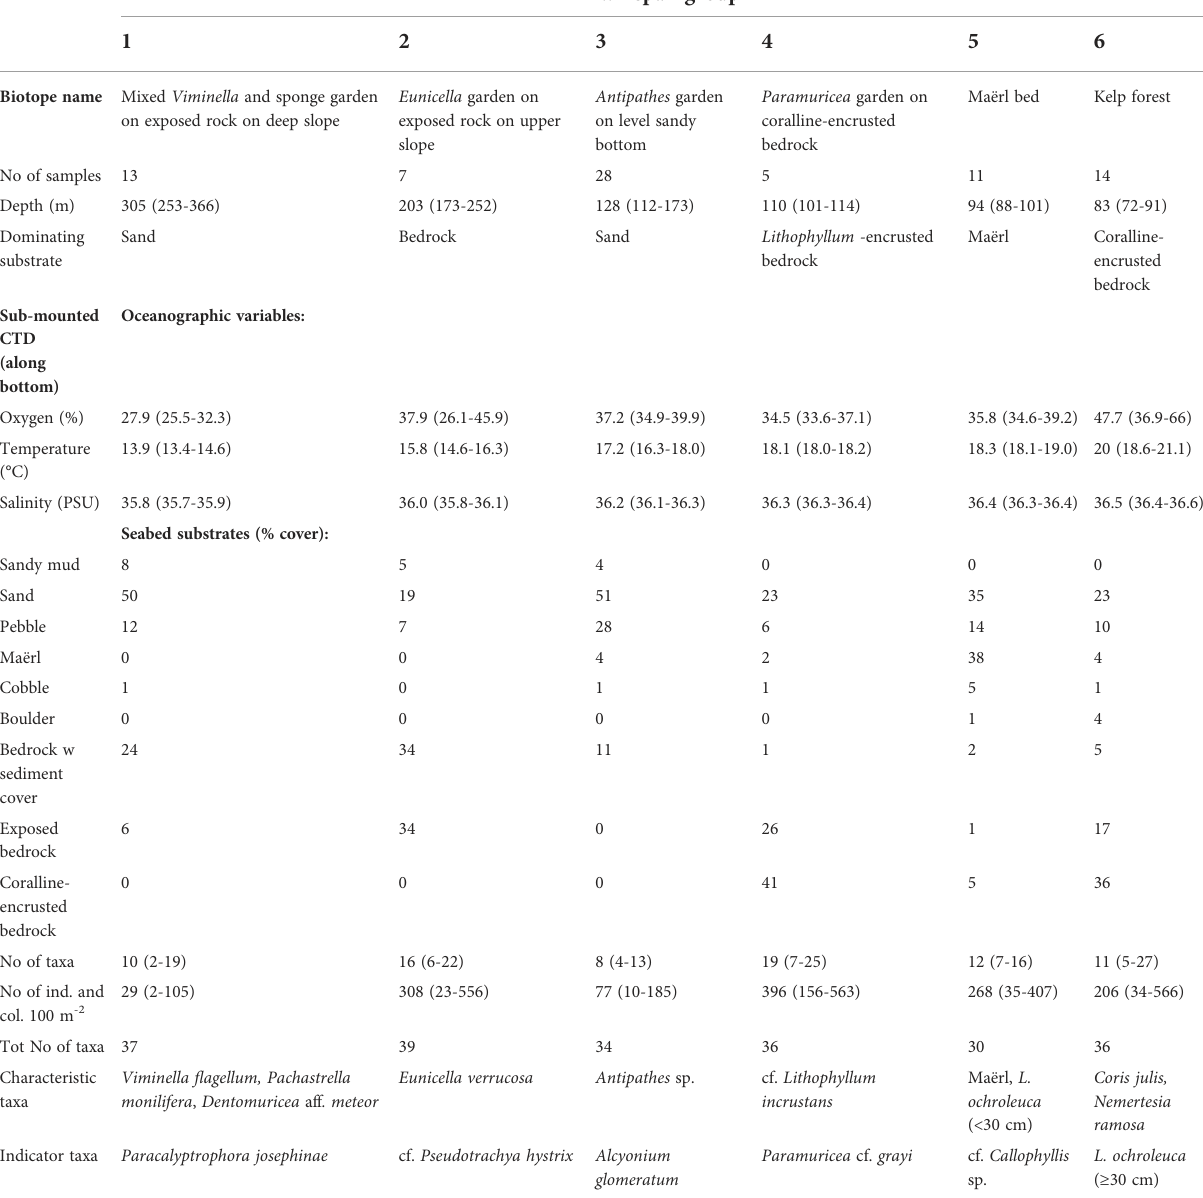
TABLE 2 Characteristic taxa and range of environmental conditions for the six biotopes identi fi ed with up to three divisions by